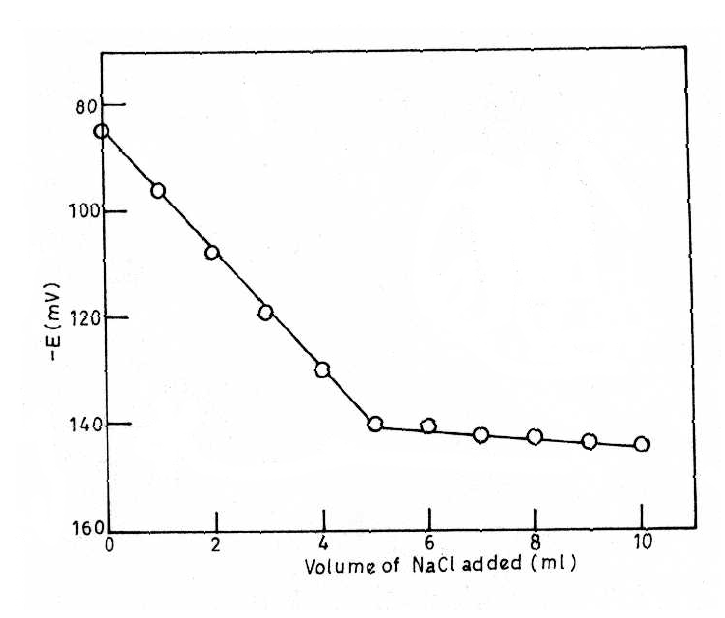
Figure 4. Plot of potentiometric titration of 20 mL of 1.0 × 10 -3 M Ag + against 4.0 ×10 -3 M NaCl